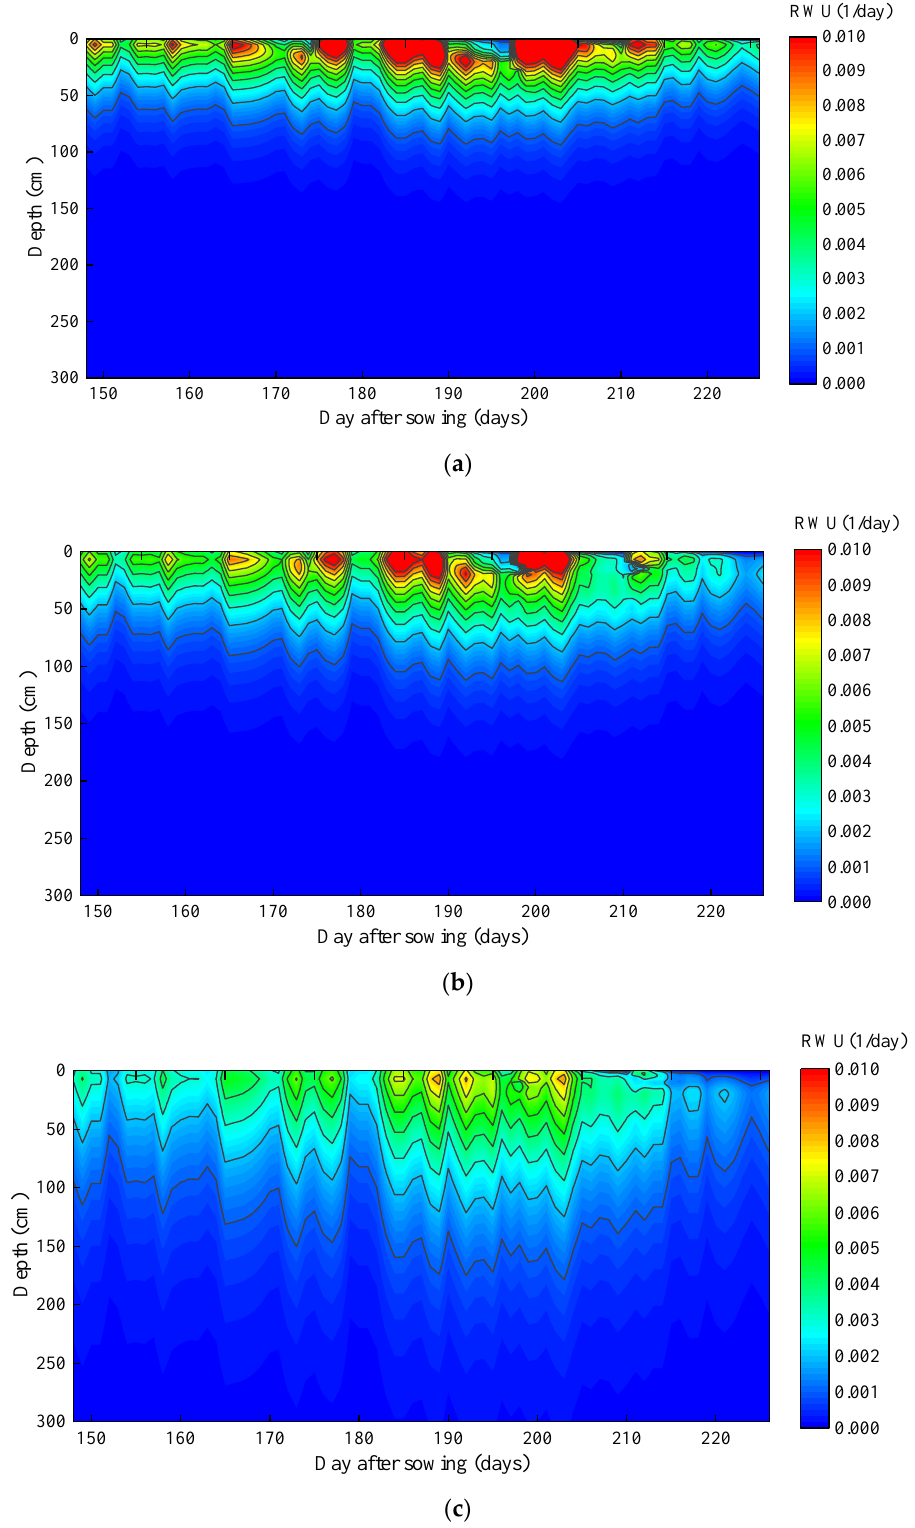
Figure 5. The dynamics of the RWU rate of winter wheat at different irrigation depths. ( a ) T1 treatment; ( b ) T2 treatment; ( c ) T3 treatment.